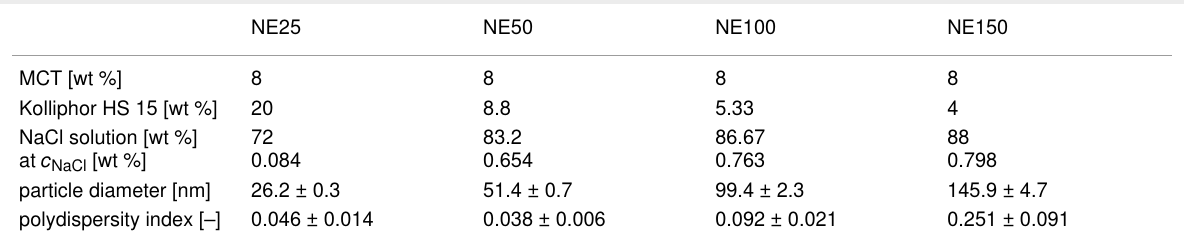
Table 1: Composition of the nanoemulsions NE25, NE50, NE100 and NE150 after shock dilution along with the particle diameters and PDI values of nine independently produced batches, c NaCl describes the salinity of the aqueous phase of the final